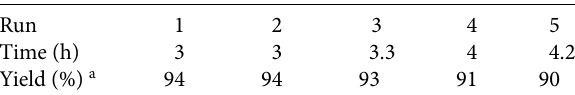
Table 4. Recyclability study of Co/Al 2 O 3 nanocatalyst in reduction of 4-chloronitrobenzene. a Run 1 2 3